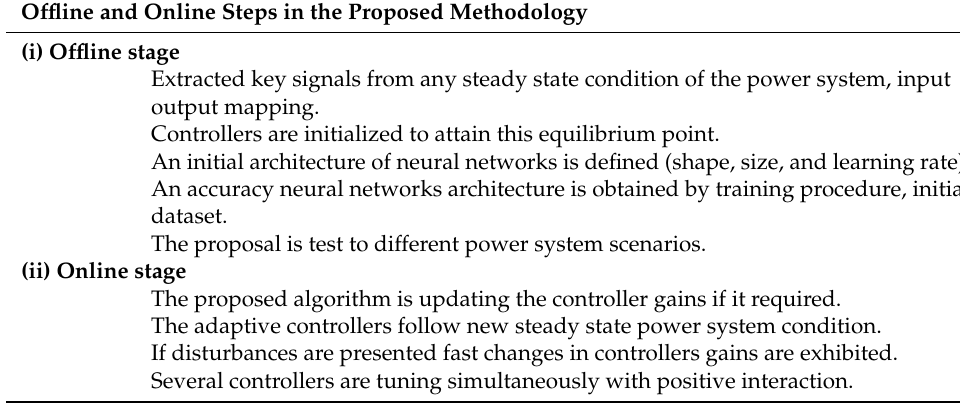
Table 1. Main stages in the proposed procedure to attain adaptive controllers. Offline and Online Steps in the Proposed